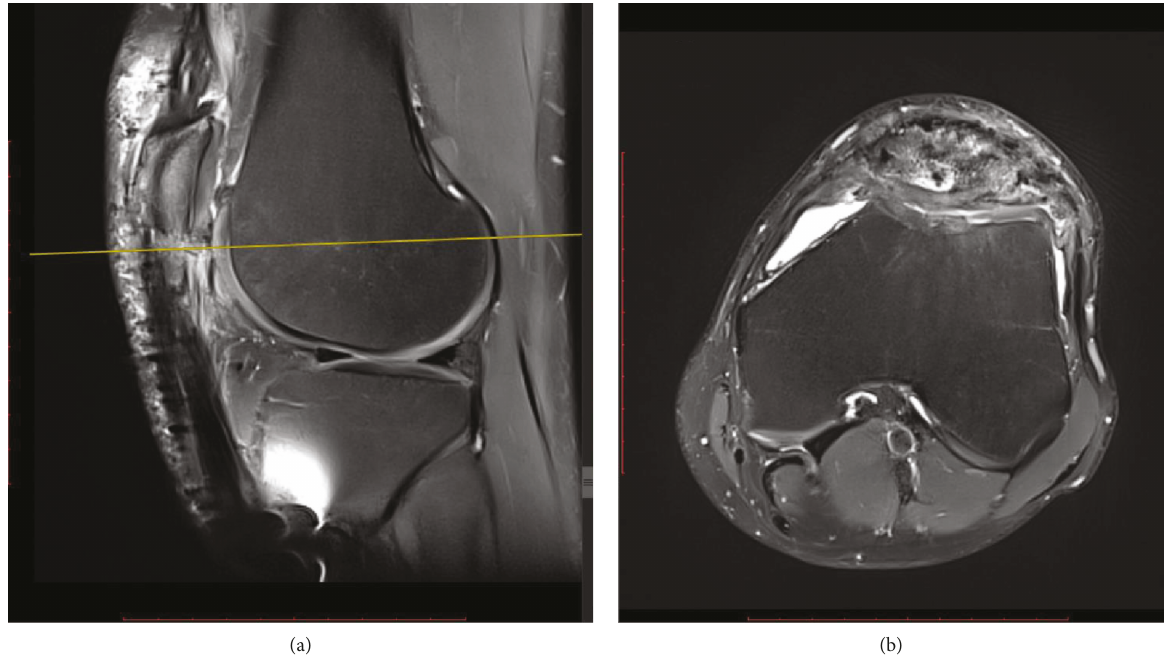
Figure 5: (a) T2 sagittal slice and (b) T2 axial slices of the control MRI at 1-year follow-up. The axial slice corresponds to the level of the fracture of the transverse patellar tunnel. Fracture is healed and continuity of the patellar tendon is